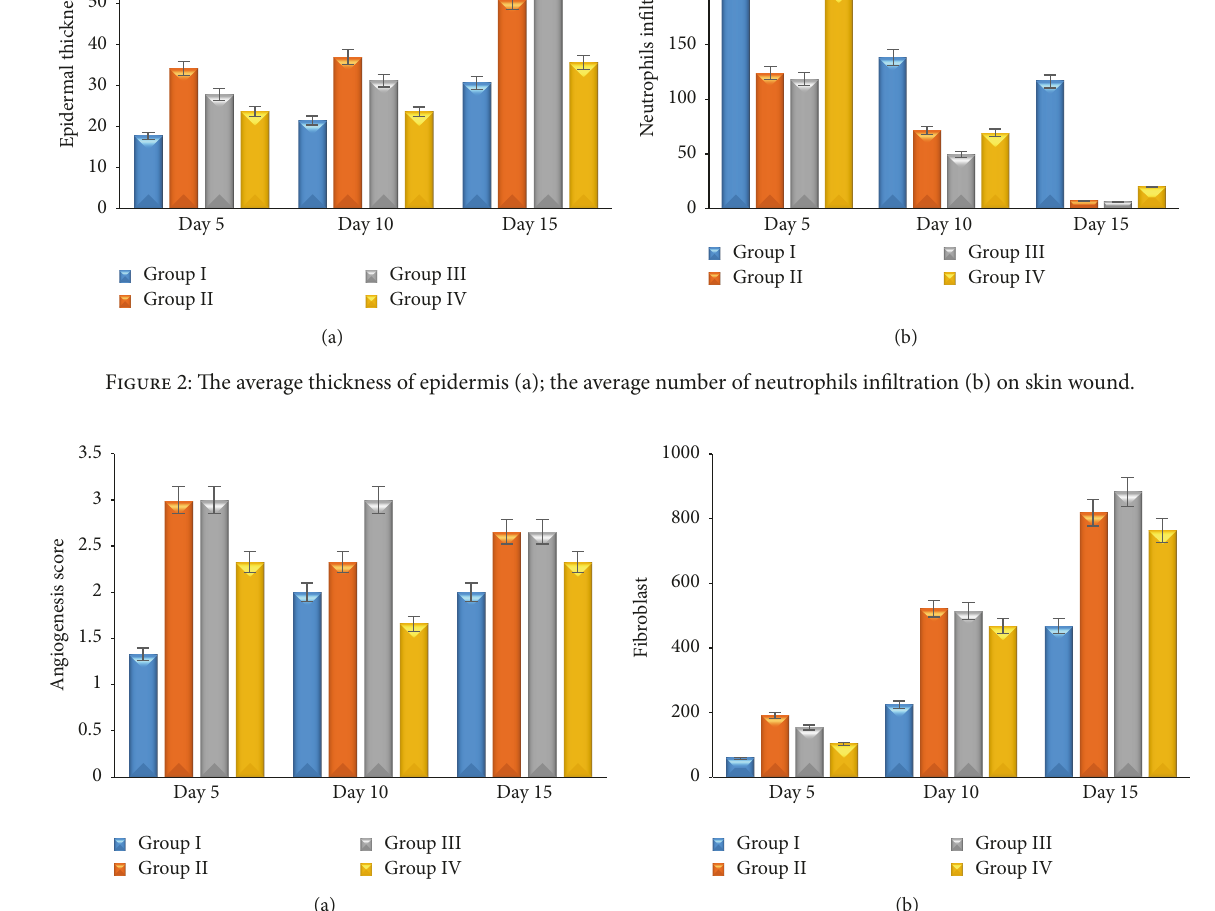
increasing CD4 + /CD8 + lymphocytes infiltration ratio earlier on wound